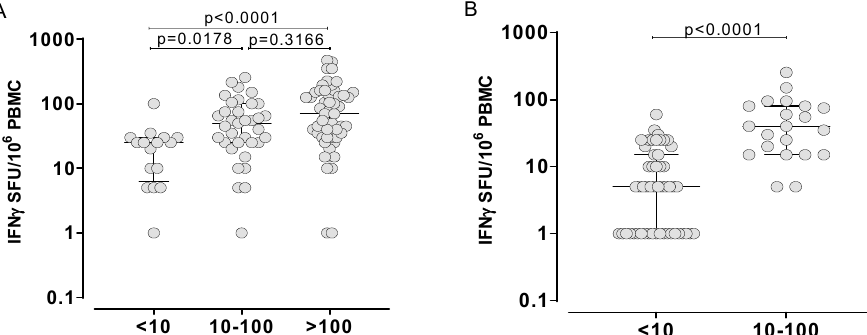
Figure 2. Distribution of SFU/million PBMC based on the IFN γ production measured by HM-WB IGRA is shown in HCWs ( A ) and ICs ( B ). Subjects were divided into three groups based on the level of IFN γ measured by HM-WB IGRA: negative (<10 pg/mL), positive at low/medium level (ranging from 10 to 100 pg/mL) and positive at high level (>100 pg/mL). Median SFU/million PBMC were measured in all the three groups and the p value for each comparison is